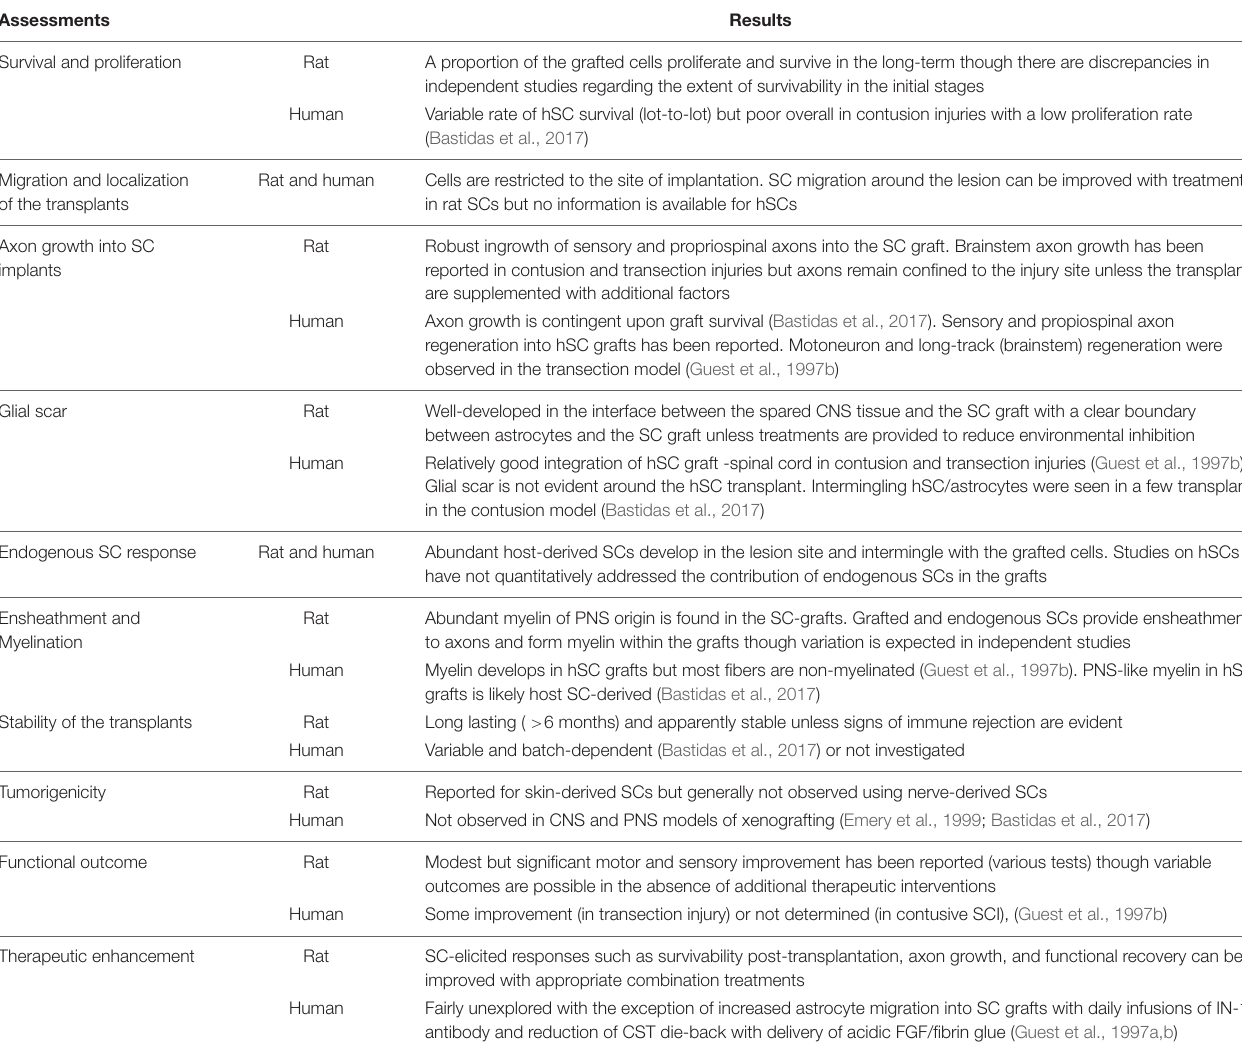
TABLE 2 | Comparison of the rat and hSC responses in spinal cord lesions. Assessments